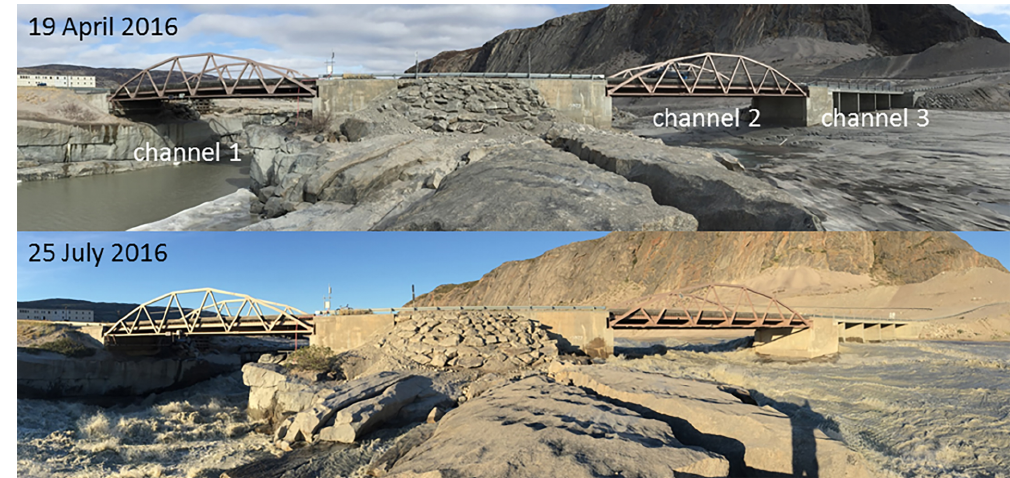
Figure 2. Pictures of the three channels underneath the Watson River bridge at low (top) and high discharge